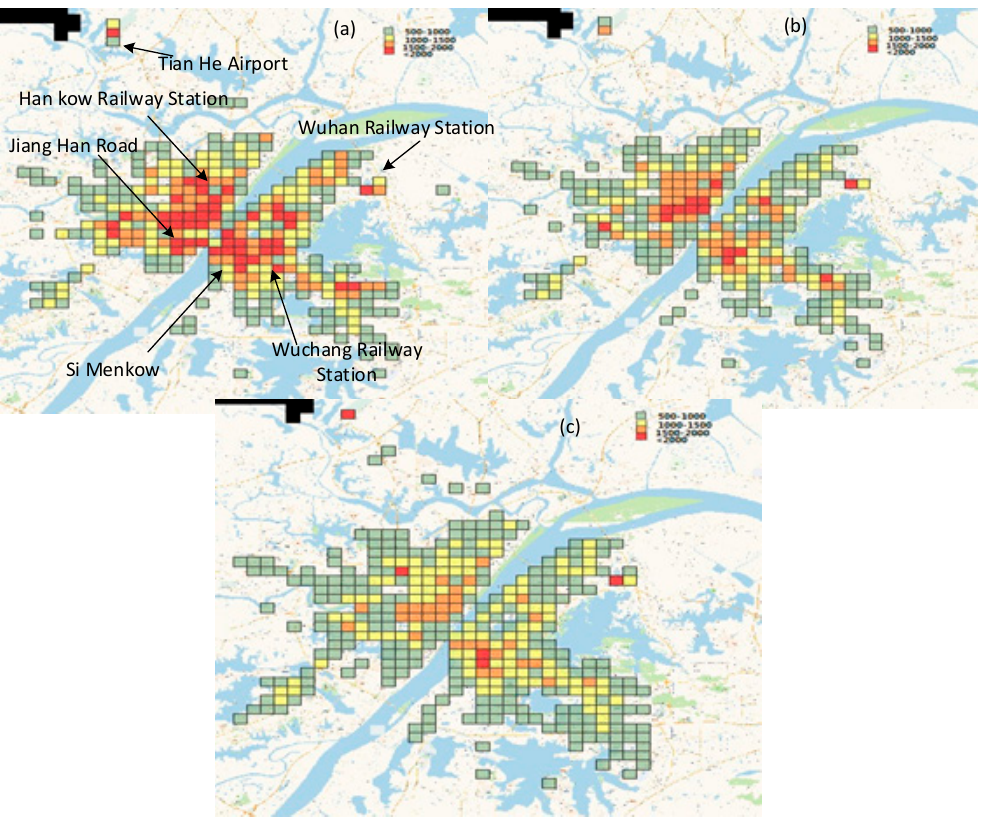
Figure 6. Spatial distribution of cruising trips of high ( a ), moderate ( b ) and low ( c ) profitability drivers.